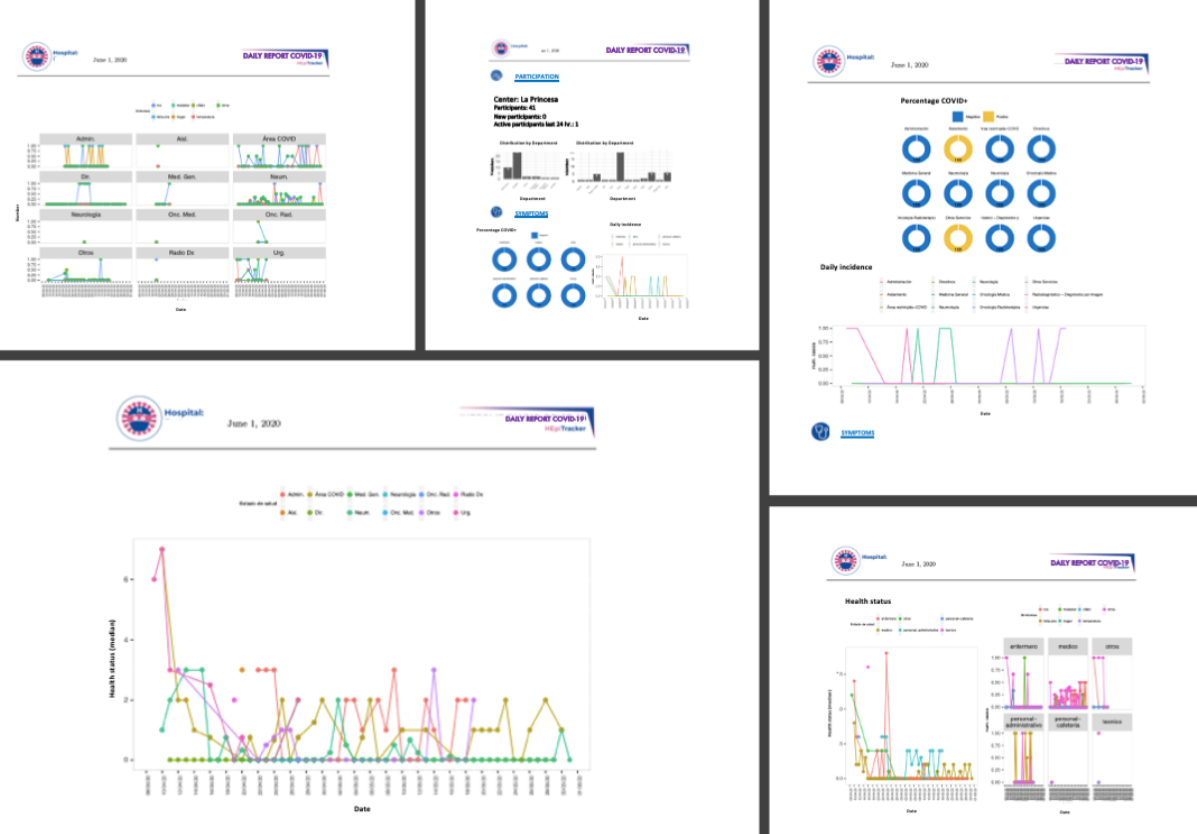
Figure 3. HEpiTracker results by hospital and by calendar